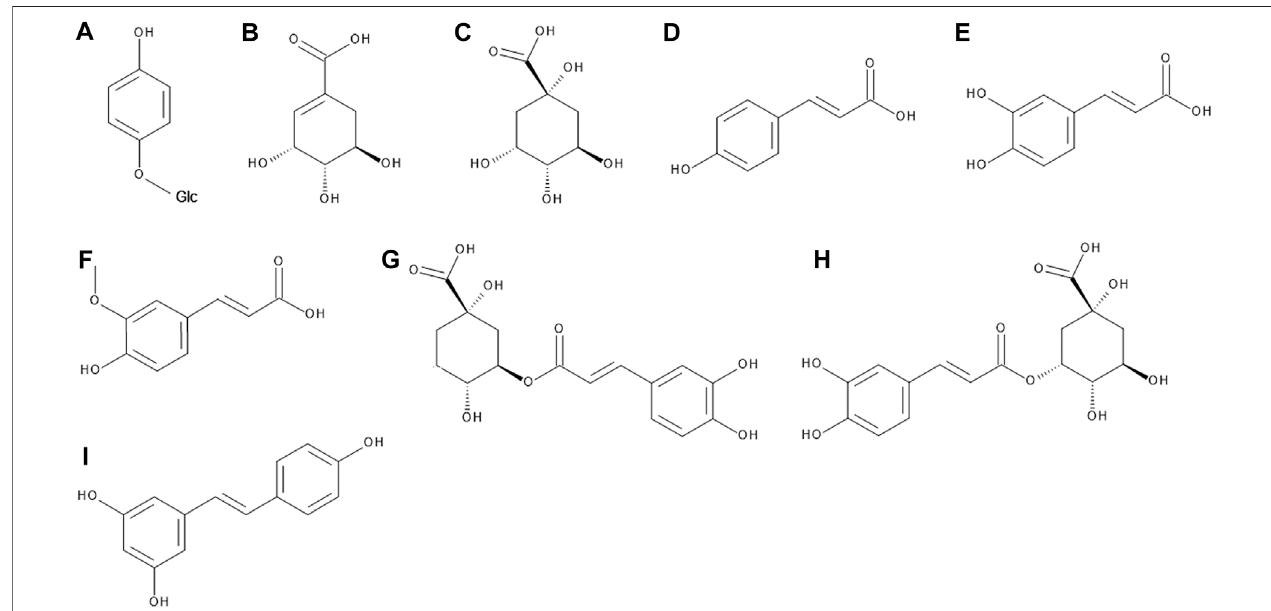
FIGURE 2 | The chemical structures of arbutin (A) , shikimic acid (B) , quinic acid (C) , p -coumaric acid (D) , caffeic acid (E) , ferulic acid (F) , chlorogenic acid (G) , neochlorogenic acid (H) , and resveratrol (I) .